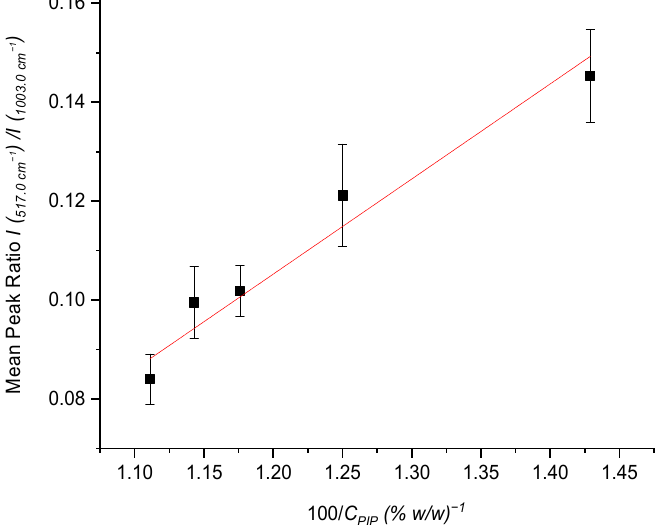
Figure 4. Calibration line for both PIP and TAZ for standard solid mixtures of them, with APIs’ mass ratio ranging from 10% TAZ/90% PIP to 30% TAZ/70% PIP.